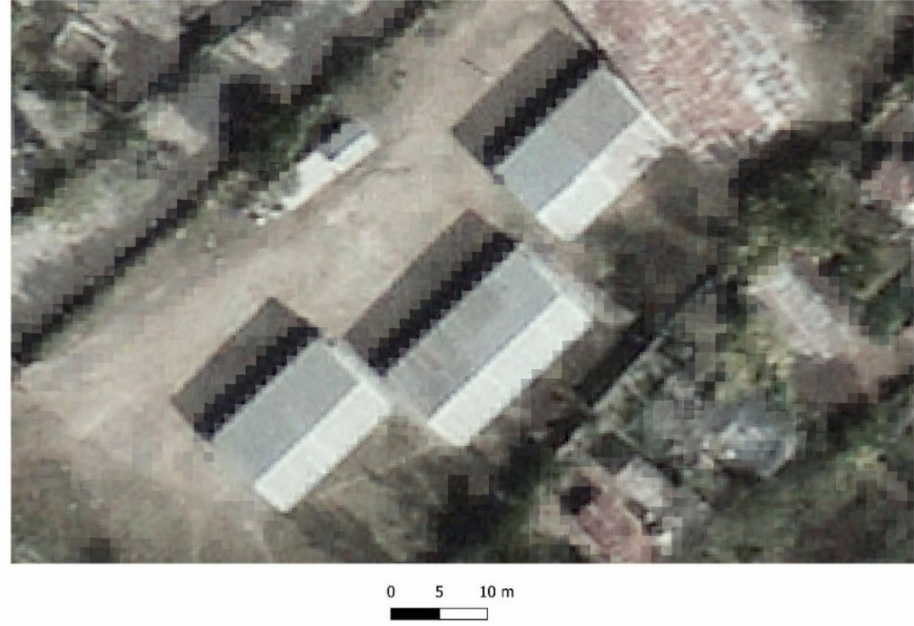
Figure 6. Example of verification of alignment of 2010 image with 2002 image. The 2010 image is displayed in RGB with 70% opacity, on top of the 2002 image, which displayed in RGB with 100% opacity. The buildings’ roofs in 2002 and 2010, visible in white, are well aligned. (Image coordinates: minimum latitude 18.993, maximum latitude 18.993; minimum longitude − 72.391, maximum longitude −